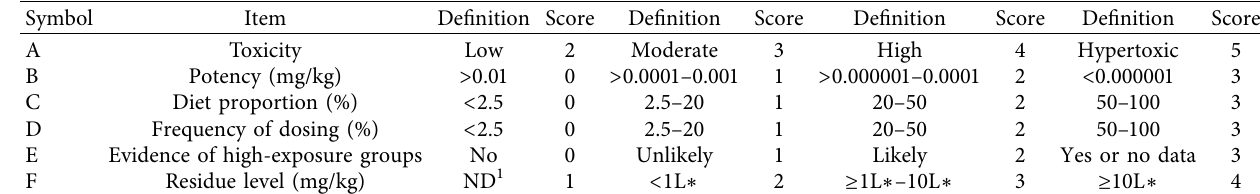
Table 1: Definition and score of A–F indices for risk ranking.